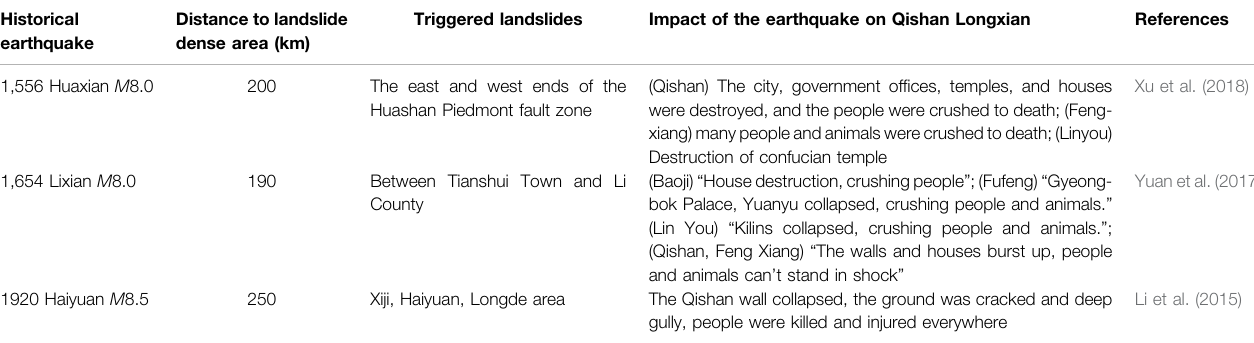
TABLE 3 | Basic parameters of three historical strong earthquakes around Qishan Longxian and the impact of the earthquake on Qishan Longxian. Historical